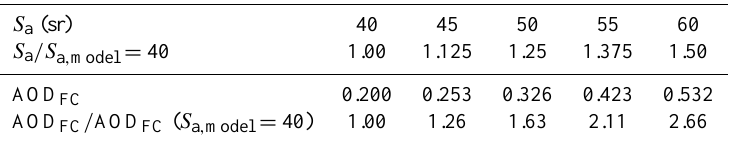
Table 4. Mean AOD FC using different S a